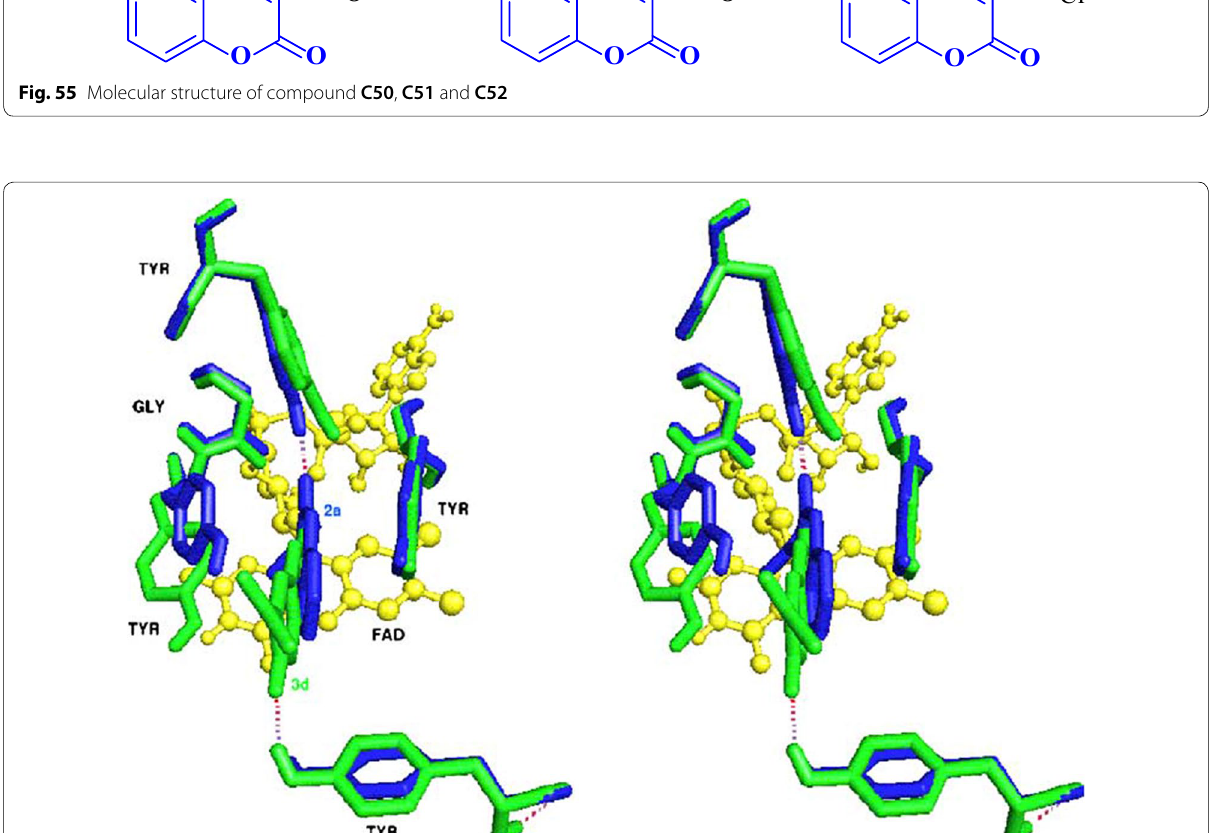
Fig. 56 Stereoview comparison of lowest energy MAO-B complexes with C52 (green polytube model) and C50 (blue polytube model) within the enzymatic cleft. The cofactor is displayed in ball-and-stick style and the hydrogen bond network in dashed lines